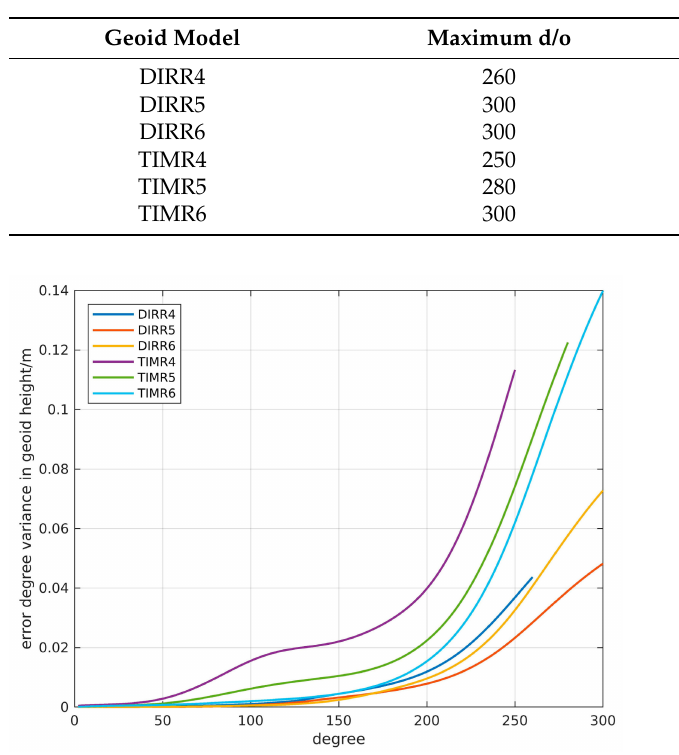
Table 1. Summary of the multigeneration GOCE-derived GGMs.